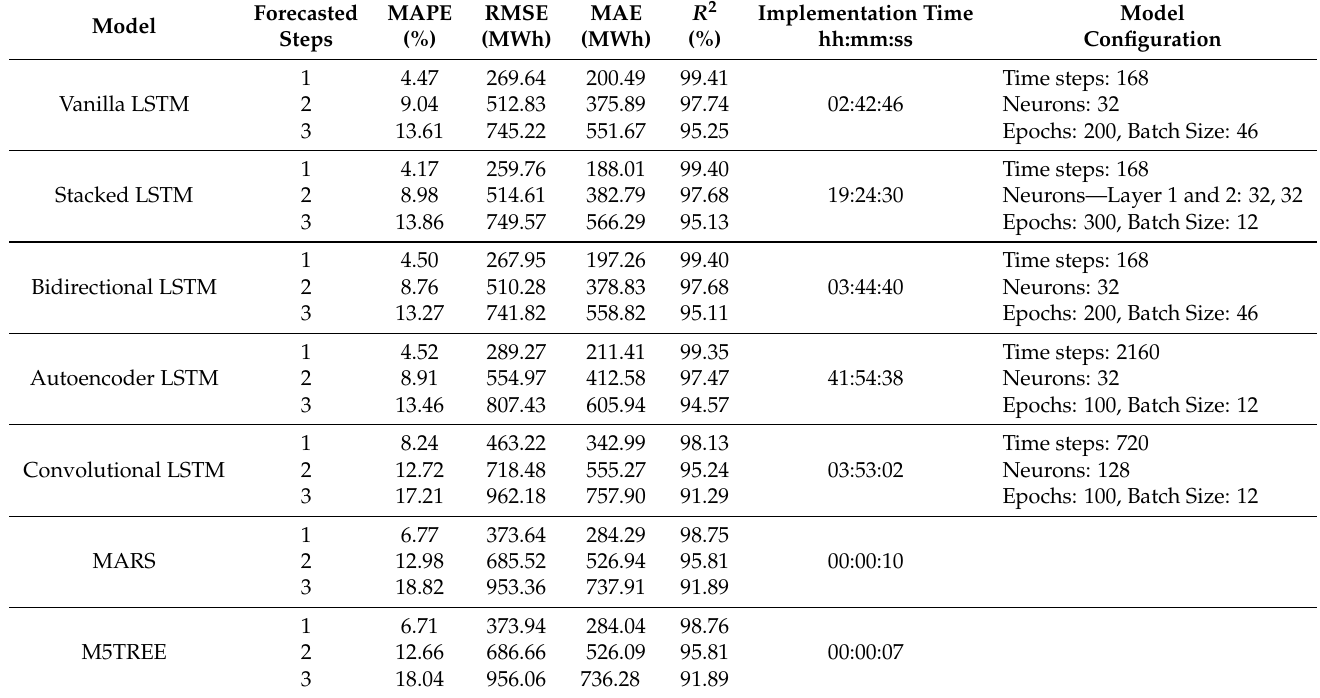
Figure 10. Scatter plots of the final LSTM models, MARS, and M5Tree for one-three steps ahead forecasting; the red line represents the 1:1 perfect line and blue line represents the regression line. Table 4. Performance summary of V-LSTM, BI-LSTM, LSTM-LSTM, CONV-LSTM, and MARS models executed for three-steps ahead